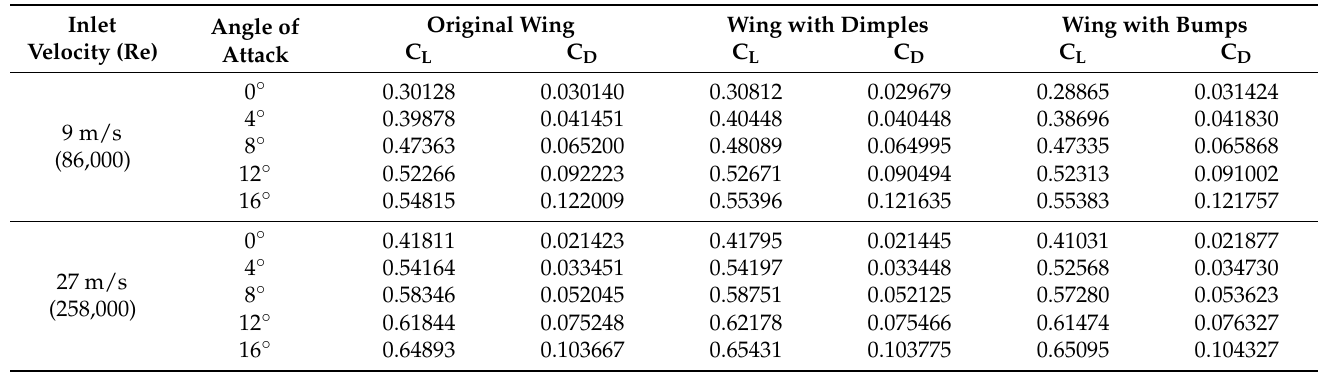
Table 6. Lift and drag coefficient for each wing configuration in all simulations.